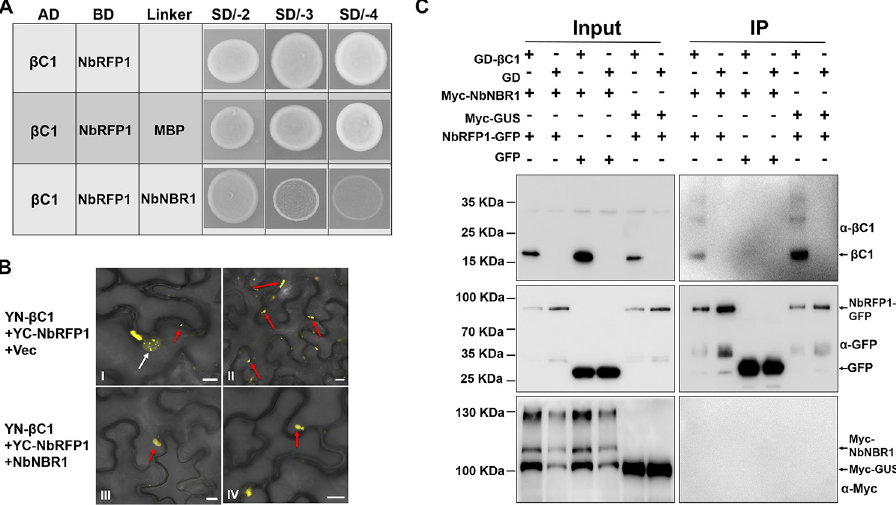
Fig 7. NbNBR1 prevents β C1 degradation by perturbing the interaction of NbRFP1 and β C1. (A) Y3H assay was used to determine the interaction among β C1, NbRFP1, and NbNBR1. Yeast cell culture co-expressing AD- β C1 +Bridge-NbRFP1-MBP was used as a control. Different yeast cell cultures transformed with the indicated plasmids were grown on the SD/-Leu-Trp (SD/-2), SD/-Leu-Met-Trp (SD/-3), and SD/-His-Leu-Met-Trp (SD/-4) media, respectively. (B) BiFC assay was performed to determine the subcellular localization patterns of YN- β C1 and YC-NbRFP1 without NbNBR1 (panel I and II) or with NbNBR1 (panel III and IV) in N . benthamiana leaf cells. Red arrows indicate granules in the cytoplasm while the white arrow indicates the nucleus. Bar = 10 μ m. (C) Immunoprecipitation assays were performed to determine the accumulation levels of GD- β C1, NbRFP1-GFP, and Myc-NbNBR1. Protein samples made from the infiltrated leaves with expressing the indicated plasmids before (Input) and after (IP) immunoprecipitation were analyzed through Western blot assays using anti- β C1, anti-GFP or anti-Myc